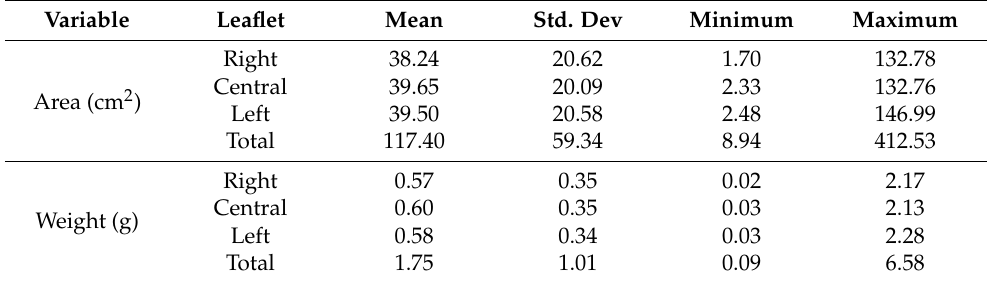
Table 1. Summary statistics for morphometric variables of leaflets of improved lines of common bean. The sample was taken to cover a large range of leaf